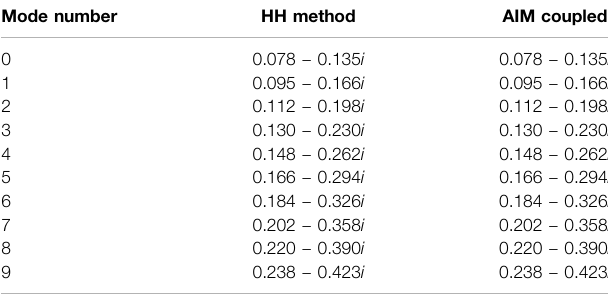
FIGURE4| Forthe fi rstfiveQNFsoftheKlein-Gordon fi eldweshowhow theimaginarypartdependsontheradiusofthe2Dblackhole(2).Weconsider a Klein-Gordon fi eld of mass m (cid:1) 1/10.